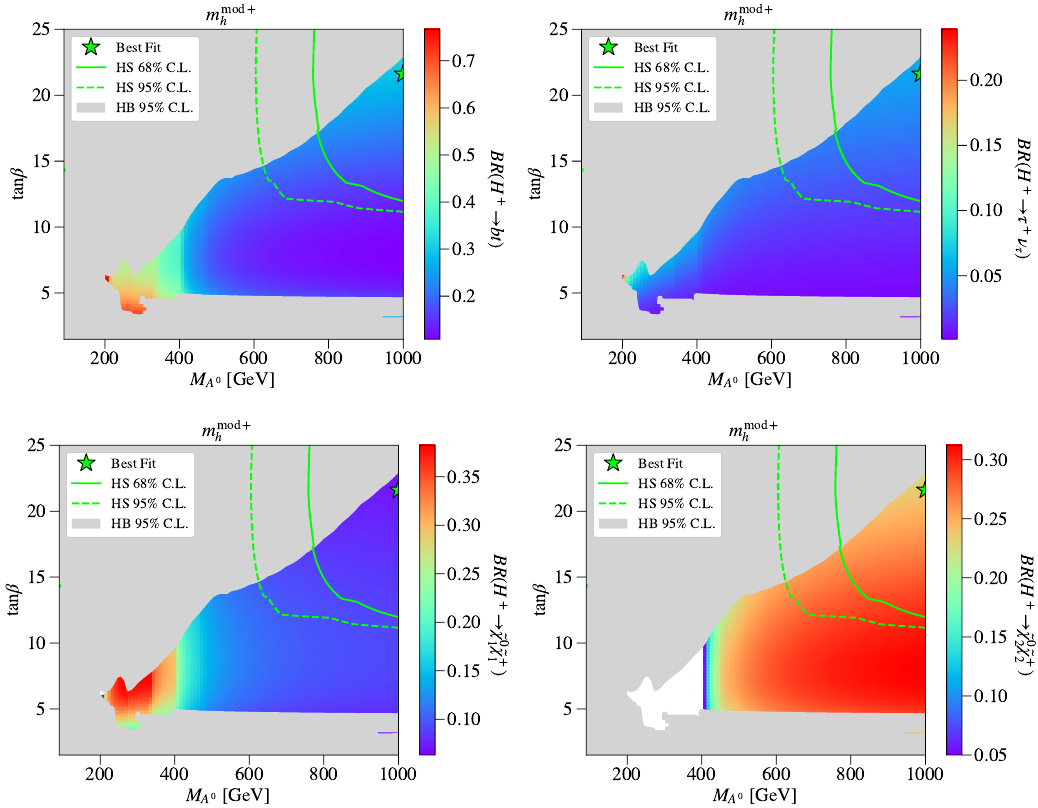
Figure 4 . Allowed regions, as shown in (cid:12)gure 3, in the ( M H + ! t (cid:22) b (top-left), H + ! (cid:22) (cid:28)(cid:23) (top-right), H + ! (cid:31) 0